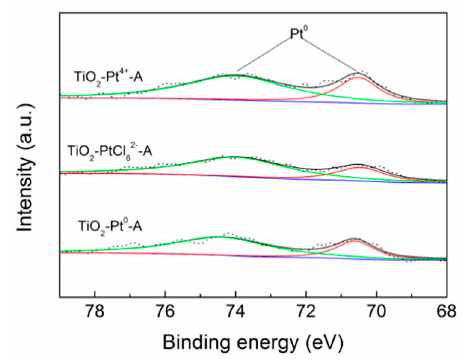
Figure 3. Pt 4f XPS spectra of the used Pt/TiO 2 samples via three different Pt sources.